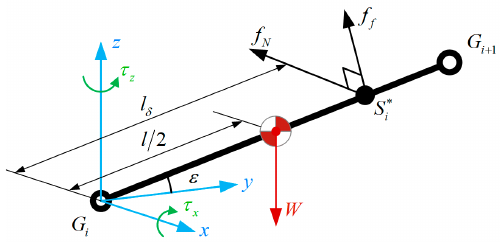
Figure 10. The forces of a single joint.